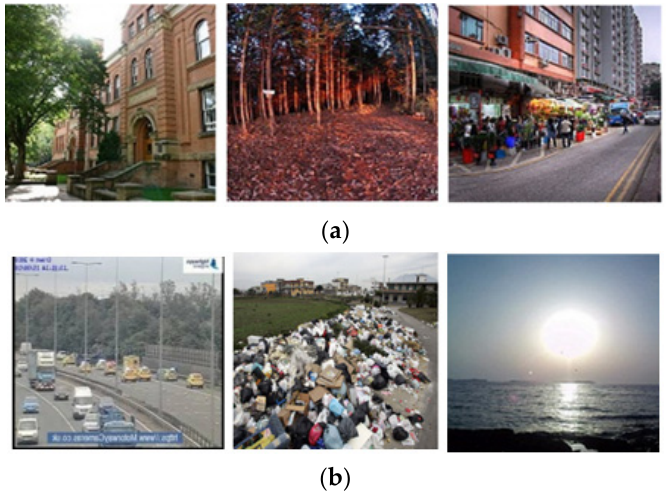
Table 9. Training Parameters of place classifier [26].